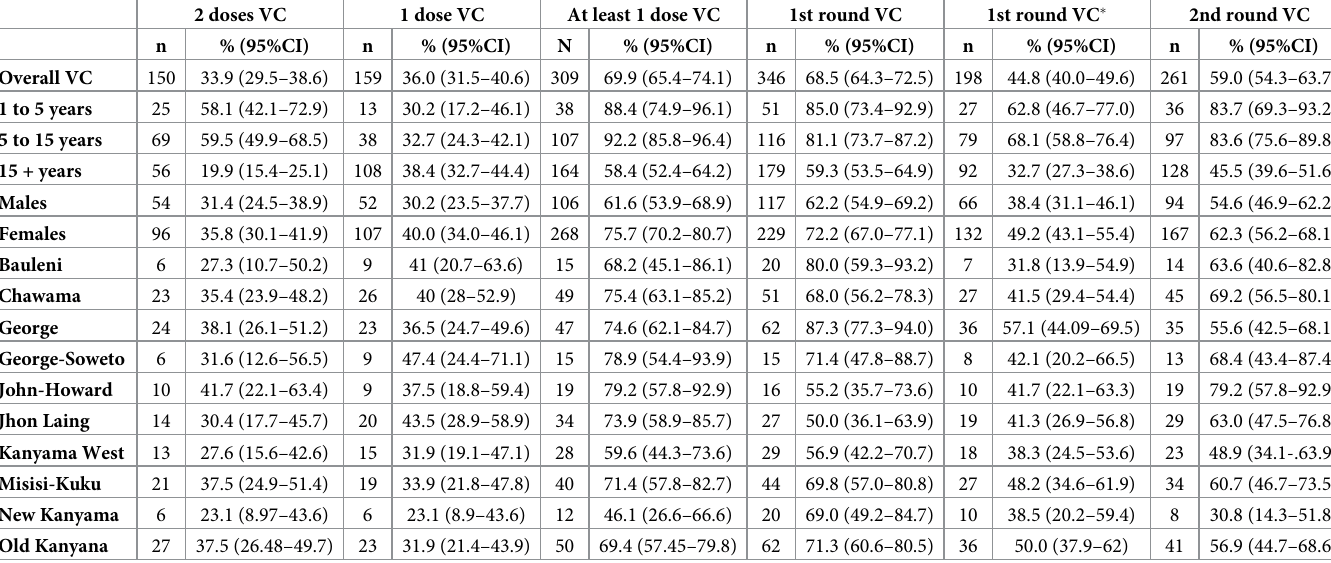
Table 1. Vaccination coverage for two, one and at least one OCV dose, and for the first and the second round of the campaign; by age group, sex and